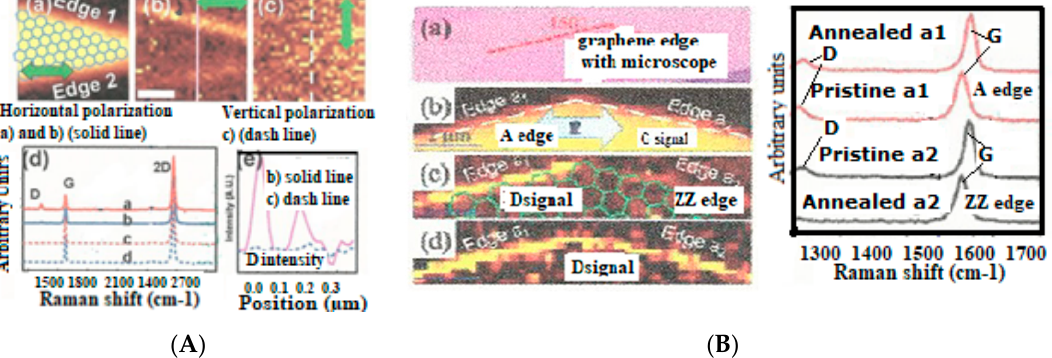
Figure 10. Micro-Raman showing locality on graphene A edges of the so-called D disorder Raman band. ( A ) Micro-Raman of graphene by Y.M. You et al. [154] with permission of Applied Physics Letters, Image of: ( a ) G peak, ( b ) “D disorder” peak (GeA peak) only on the A edge ( c ) GeA peak with vertical laser polarization. No D’ peak and C5 / C7 band (no disorder). ( d ) Raman spectra on bulk. ( e ) Raman intensity geometric distribution of D signal ( B ) Micro Raman spectra showing graphene ZZ edge transformation into the Aedge with thermal annealing at ~300 ◦ C adapted from Y.N. Xu [155] with permission of the ACS Nano. No C5 / C7 band at ~1500 / 1530 cm − 1 . Pristine non-annealed graphene shows tensile downshift of ~20 cm − 1 indicating that it was prepared by CVD. Stress disappears with annealing temperature at ~300 ◦ C. ( a ) graphene edge location, ( b ) Image of G peak on bulk, ( c ) Image of D peak only on A edge after annealing, ( d ) Image of D peak on pristine graphene flake.